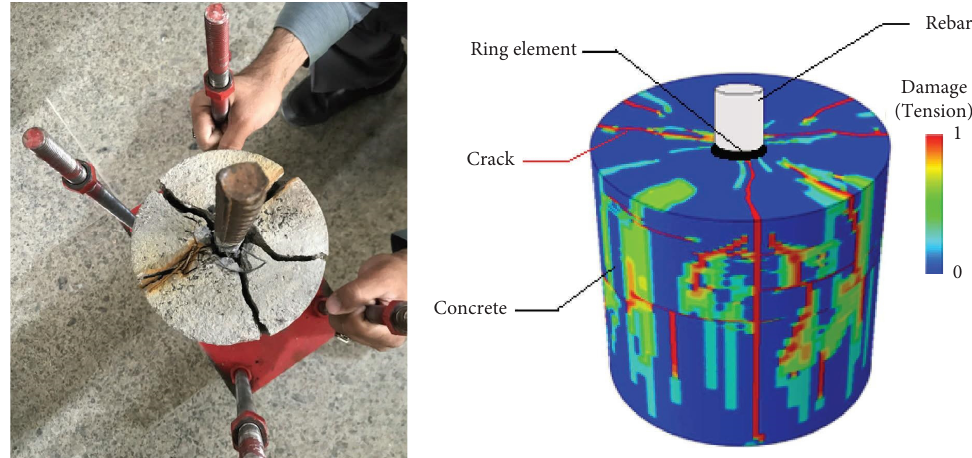
Figure 6: Te comparison of the failure pattern of the pull-out test and simulated with the CDP model.